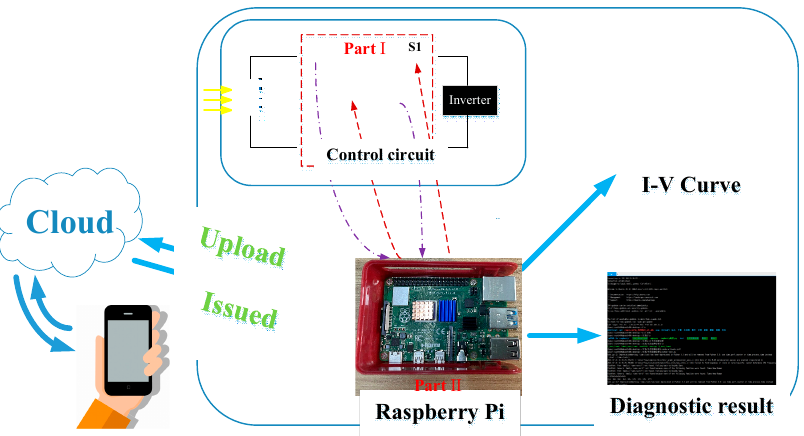
Figure 11. Workflow of the edge diagnosis system.